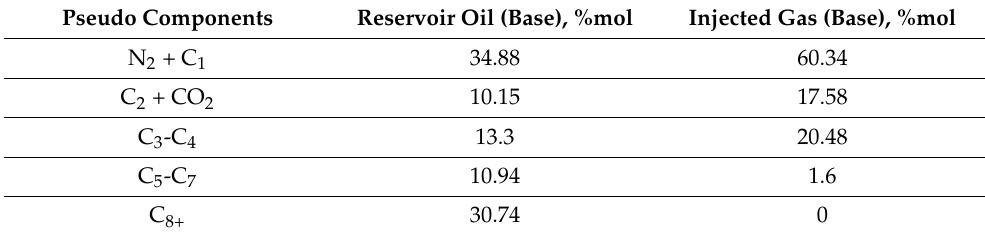
Table 2. The reservoir oil and injection gas compositions used the in